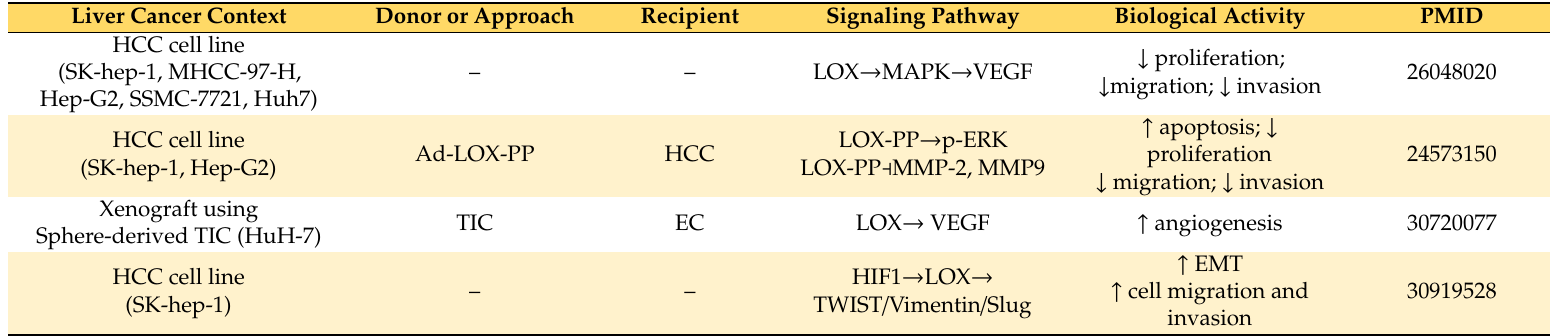
Table 2. Roles and mechanisms of LOX in hepatocarcinogenic progression and the